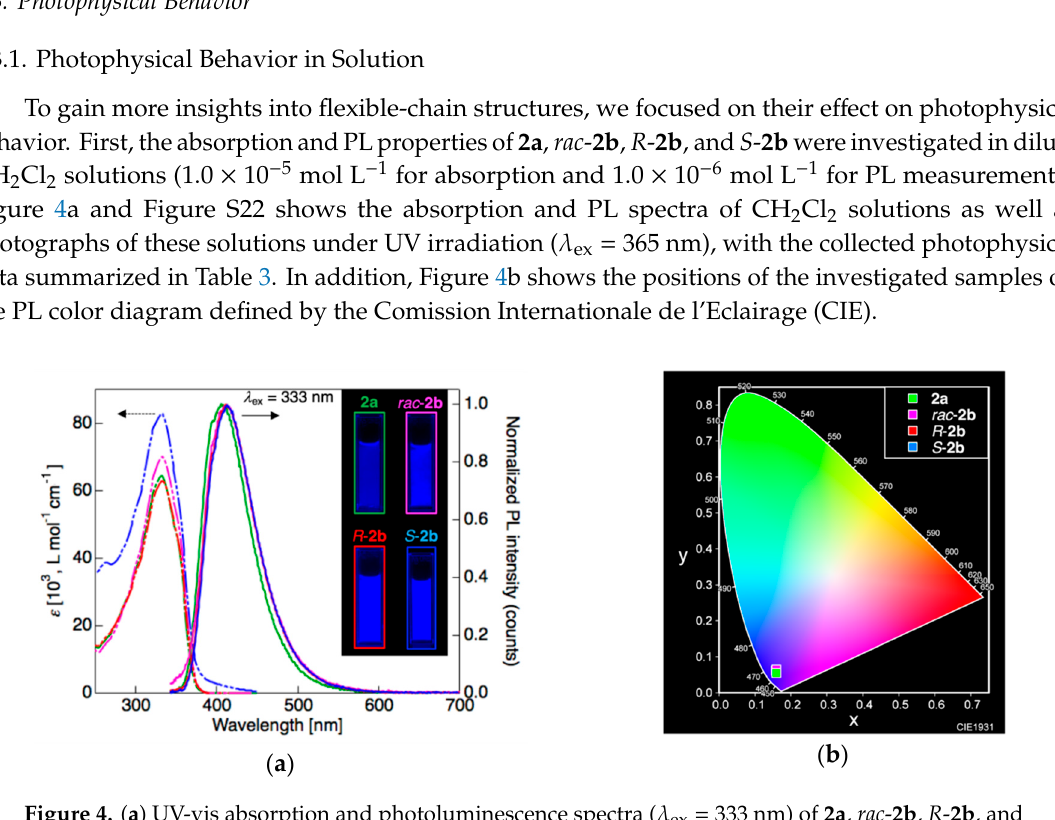
Figure 4. ( a ) UV-vis absorption and photoluminescence spectra ( λ ex = 333 nm) of 2a , rac - 2b , R - 2b , and S - 2b in CH 2 Cl 2 solutions and photographs of these solutions under UV irradiation ( λ ex = 365 nm). ( b ) Positions of the samples in ( a ) on the Comission Internationale de l’Eclairage (CIE) color diagram. Table 3. Photophysical properties of 2a , rac - 2b , R - 2b , and S - 2b in solution. Molecule Solvent ( ε ) 1